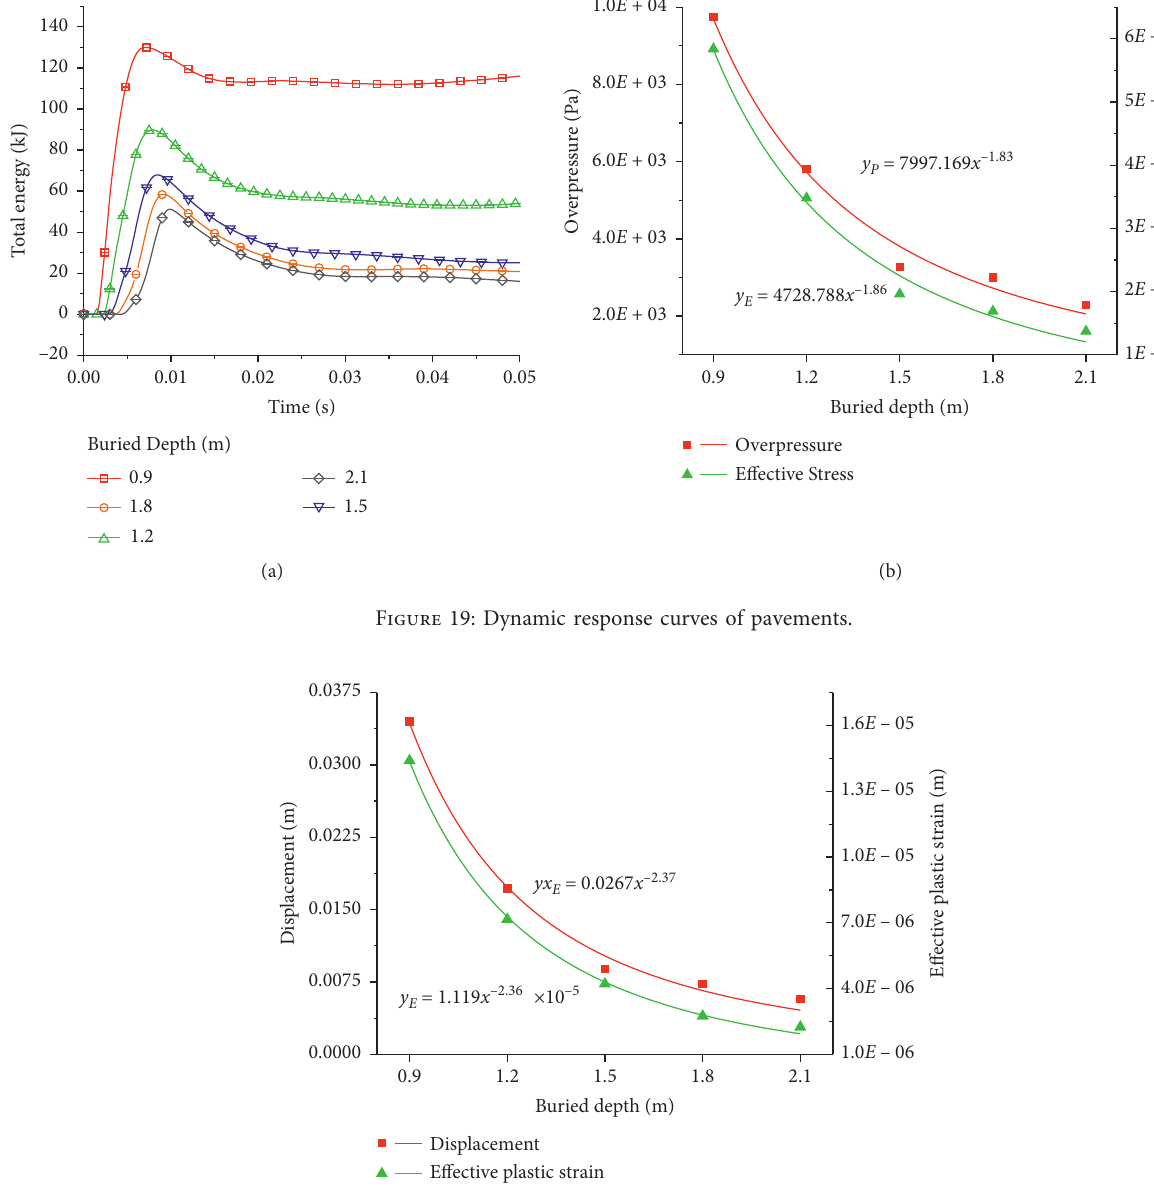
Figure 20: Relationship between buried depth and deformation of pavement.